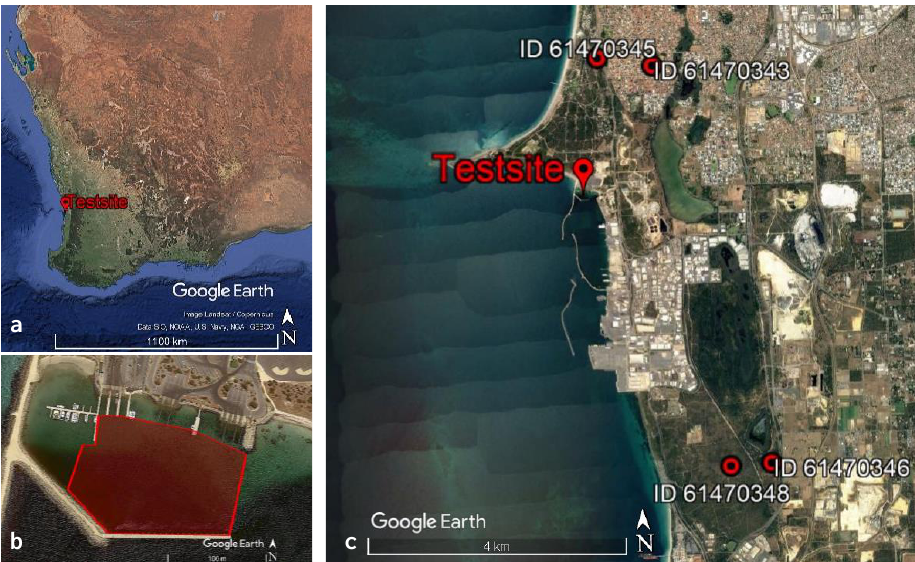
Figure 2. ( a ) Overview map; ( b ) test site detail; ( c ) overview map, red polygon indicates the test site, locations of groundwater wells are indicated by their IDs.